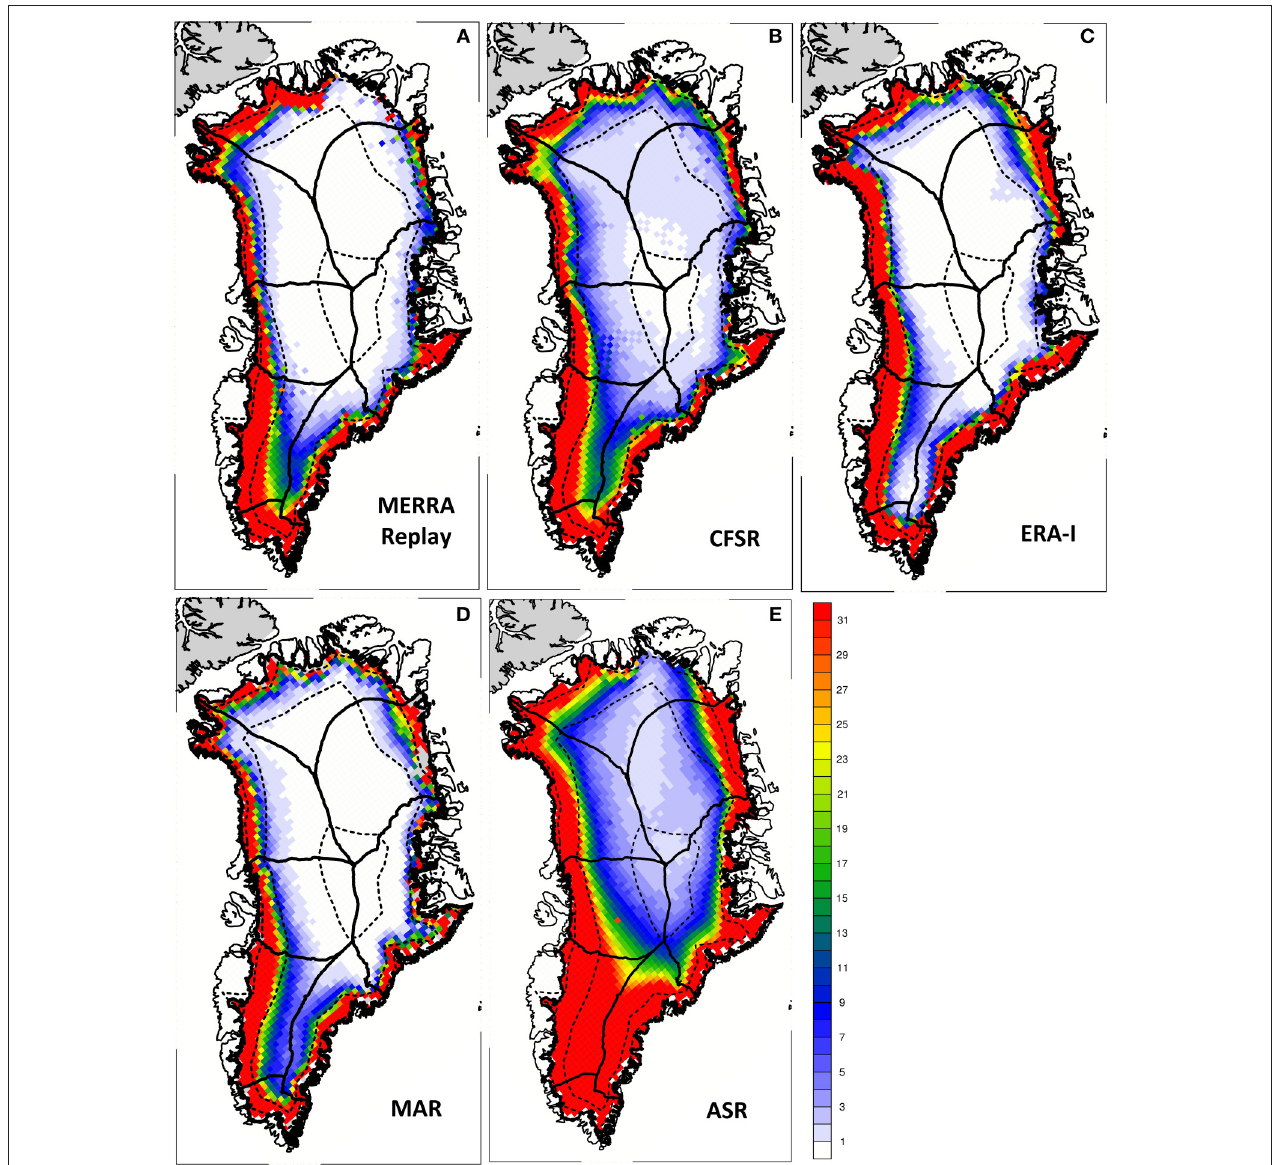
FIGURE 5 | Average number of GrIS melt days per year for (A) MERRA-replay (B) CFSR, (C) ERA-I, (D) MAR, and (E) ASR. Boundaries of major GrIS drainage basins of Zwally et al. (2012) are indicated, and surface orography from Bamber et al. (2001) is indicated with dashed contours for every 1000m of